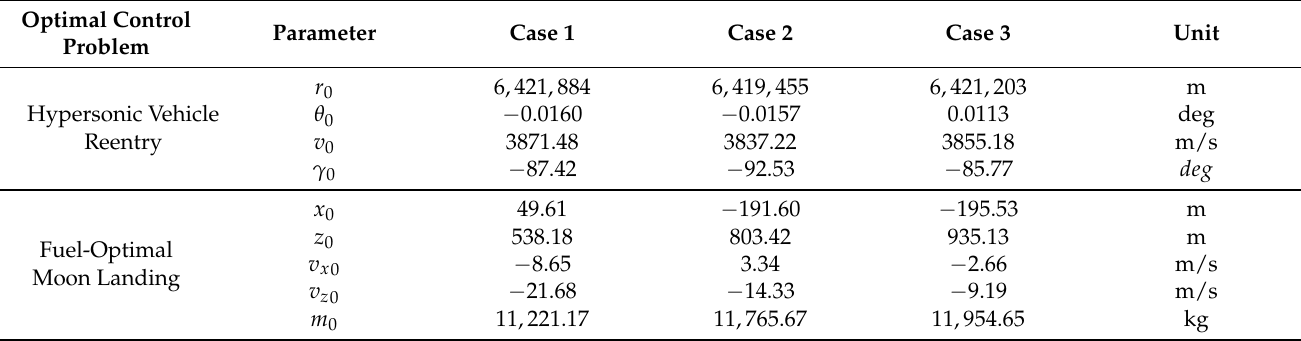
Table 6. Initial state vectors of three simulation cases.